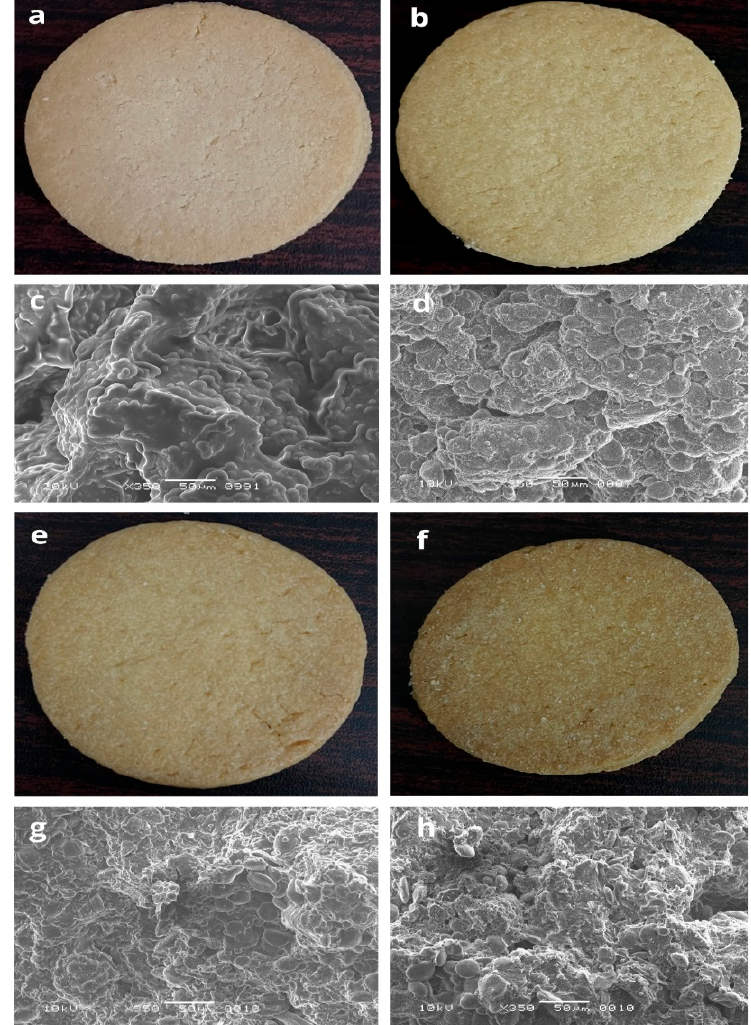
Figure 1. Appearance and scanning electron microscopic images (at X 350 magnification) of gluten-free biscuit samples: ( a , c ) T0; RF:DPF:APF (100:0:0); ( b , d ) T1; RF:DPF:APF (90:5:5), ( e , g ) T2;